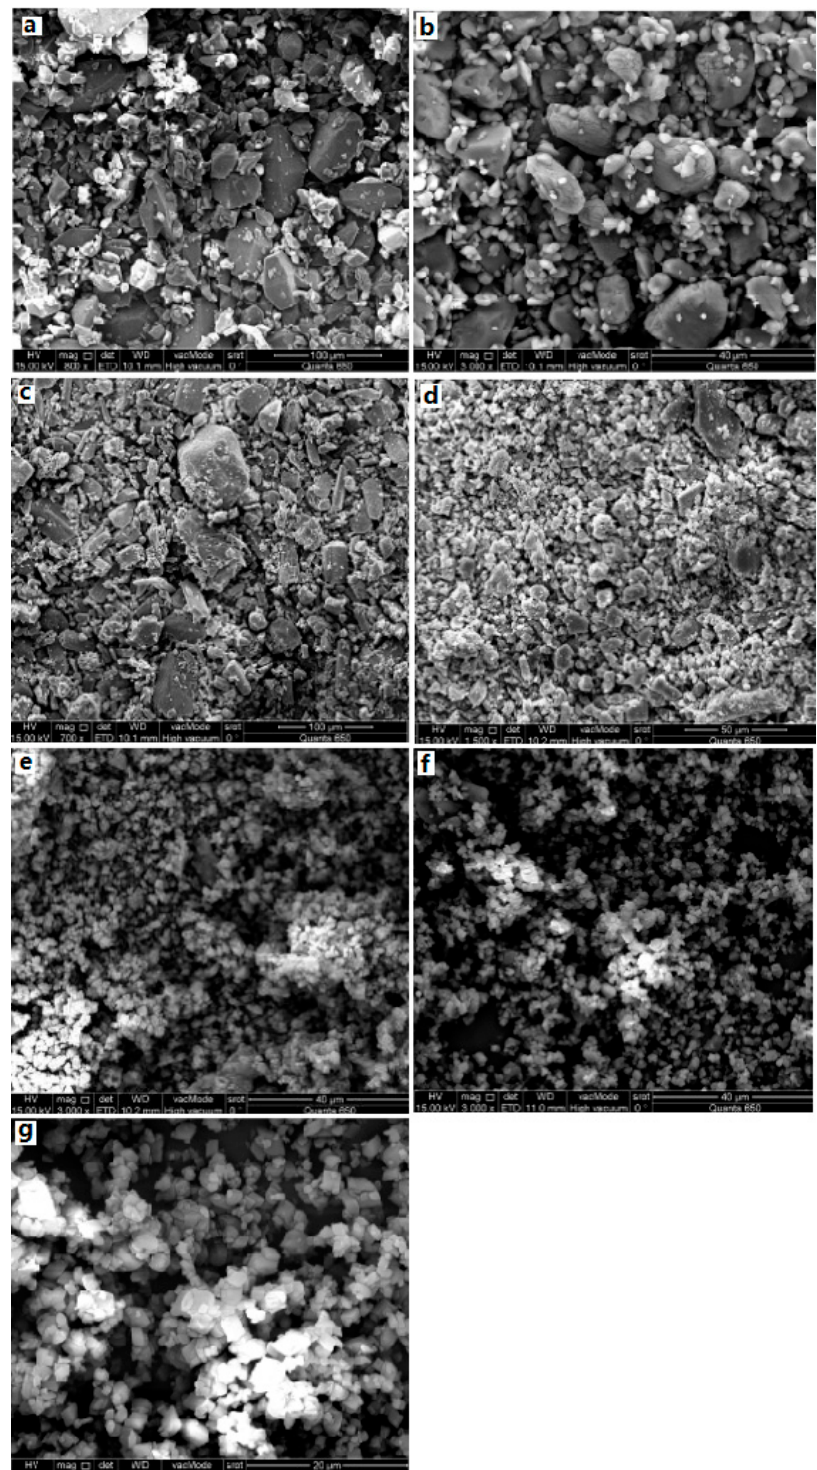
Figure 9. SEM photographs of CL-20, HMX and CL-20/HMX cocrystals at different mixing time. ( a ) CL-20; ( b ) HMX; ( c ) CL-20/HMX cocrystals for 5 min; ( d ) CL-20/HMX cocrystals for 15 min; ( e ) CL-20/HMX cocrystals for 30 min; ( f ) CL-20/HMX cocrystals for 45 min; ( g ) CL-20/HMX cocrystals for 60 min [6], with permission from Han Neng Cai Liao, 2020.